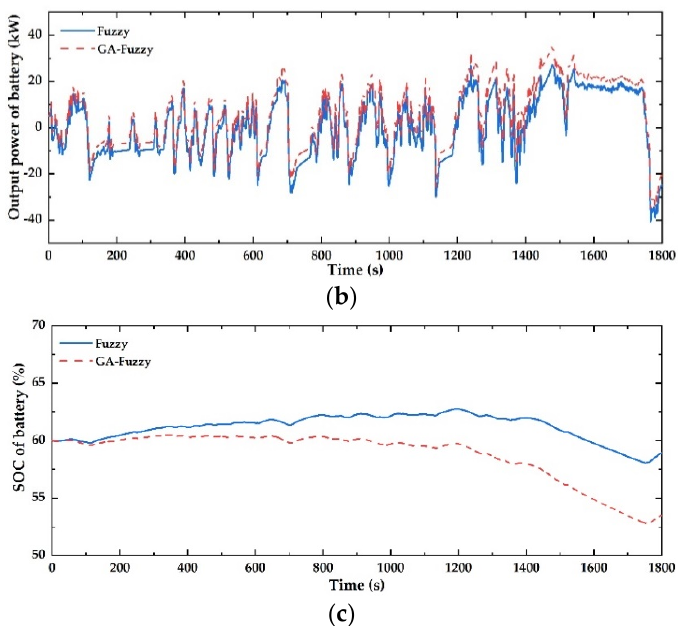
Figure 9. Comparison of the fuzzy and GA-fuzzy simulation results. ( a ) Fuel cell net output power; ( b ) Battery output power; ( c ) Battery SOC fluctuation.